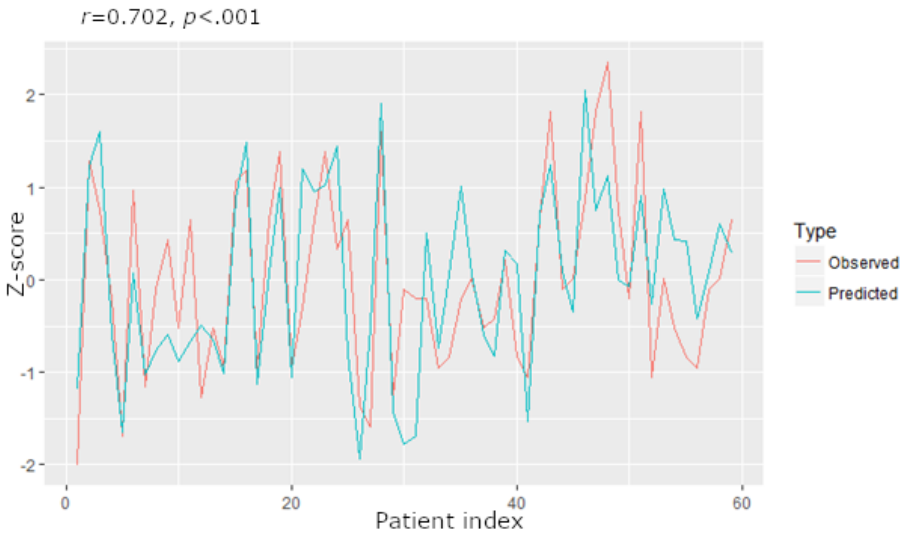
Figure 2. Z-scores of the predicted social anxiety disorder (SAD) severity and the observed SAD symptom severity for each participant. Note that the patient index represents each of the 59 participants and not a continuous metric. SAD: social anxiety disorder; SIAS: social interaction anxiety